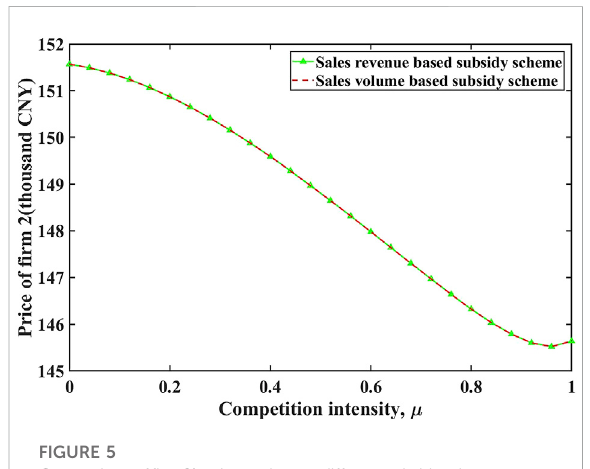
FIGURE 7 Comparison of fi rm 2 ’ s pro fi t under two different subsidy schemes.